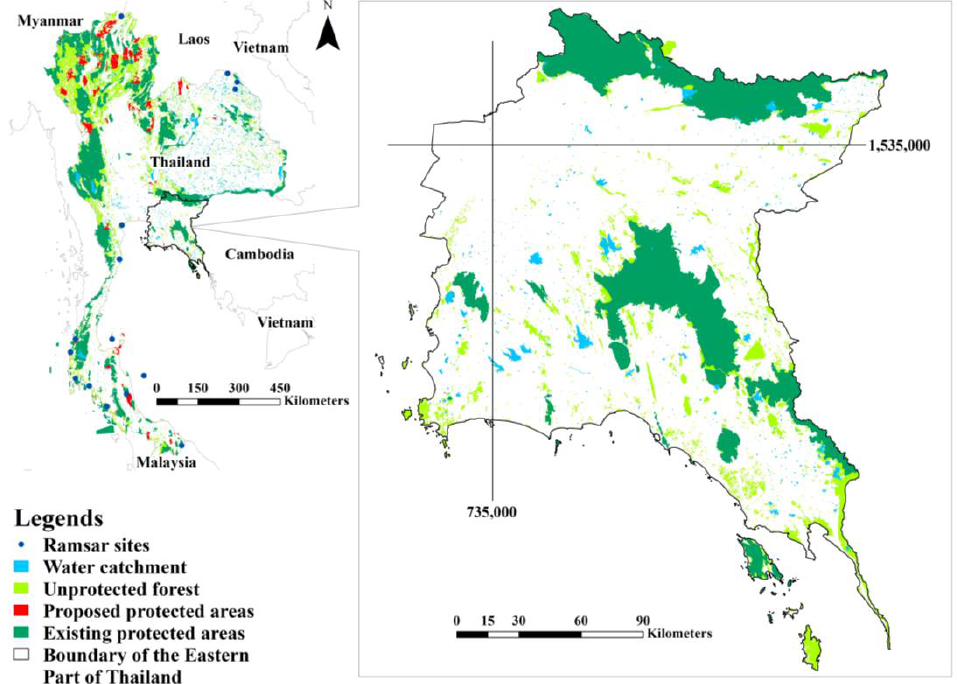
Figure 1. Land use of the Eastern Forest Complex (EFCOM) in 2020. Adapted with permission from DNP [35] and Pomoim et al. [37].